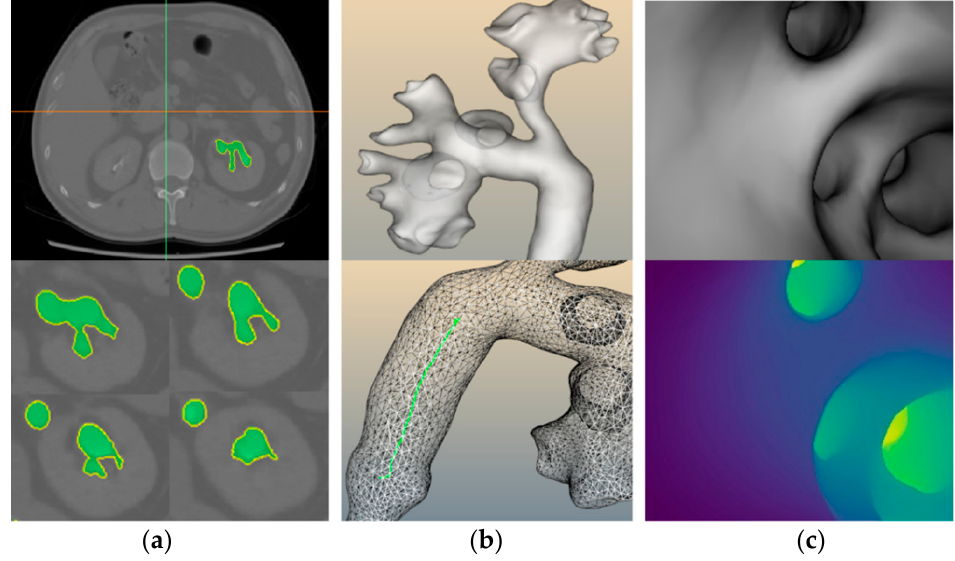
Figure 2. Dataset acquisition process. ( a ) shows CT images and the segmentation of key anatomical sites; ( b ) represents the reconstructed 3D model of the kidney and its center path; ( c ) denotes a pair of SI-DM images.